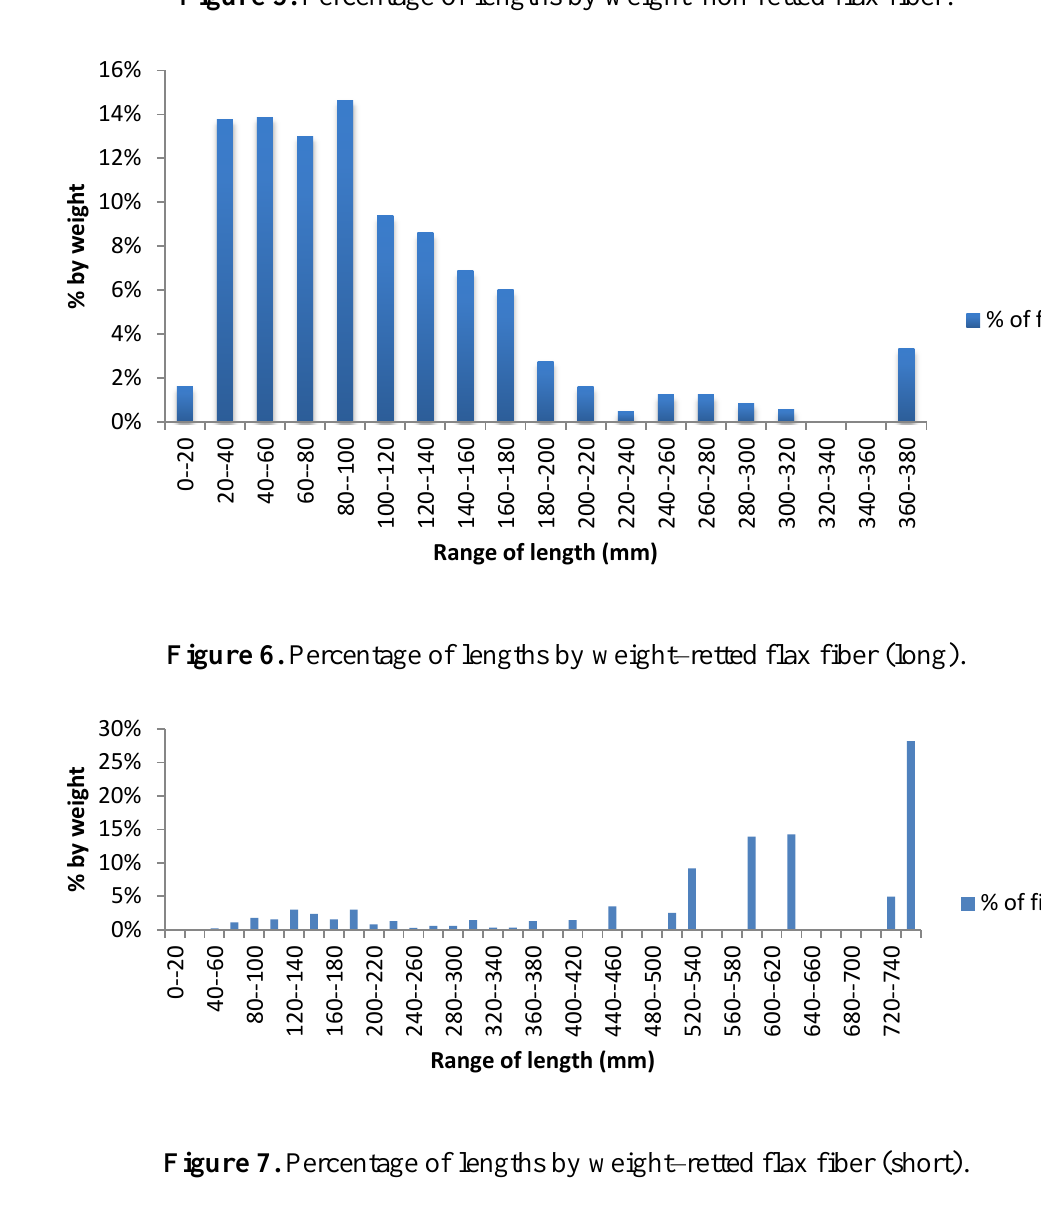
Figure 5. Percentage of lengths by weight–non-retted flax fiber.